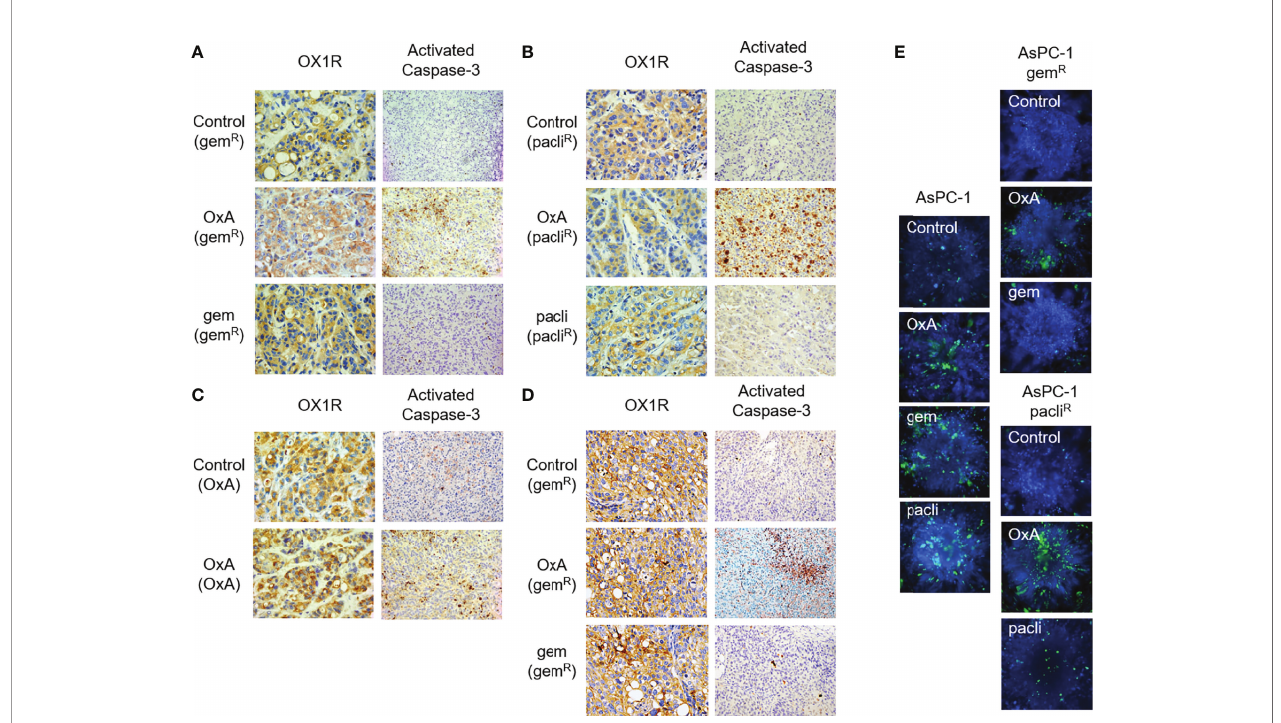
FIGURE 6 | Histological analysis of resected tumors from Run 02 experiments. (A) OX1R expression and caspase-3 activation in gemcitabine-chemoresistant AsPC-1 tumors (gem R ) treated with PBS (Control), OxA (OxA), and gemcitabine (gem). (B) OX1R expression and caspase-3 activation in Nab-paclitaxel- chemoresistant AsPC-1 tumors (pacli R ) treated with PBS (Control), OxA (OxA), and Nab-paclitaxel (pacli). (C) OX1R expression and caspase-3 activation in 50 days OxA-treated tumors (OxA) treated with PBS (control) and OxA (OxA). (D) OX1R expression and caspase-3 activation in gemcitabine-chemoresistant tumors obtained by xenografting of 50 days gemcitabine-treated PDAC15 cells (gem R ) treated with PBS (control), OxA (OxA), and gemcitabine (gem). (E) Cell viability determination of spheroids developed with parental AsPC-1, gemcitabine-resistant, and Nab-paclitaxel-resistant AsPC-1 cells isolated in Run 02 experiment. Magni fi cation was 40× (OX1R expression) and 20× (caspase-3